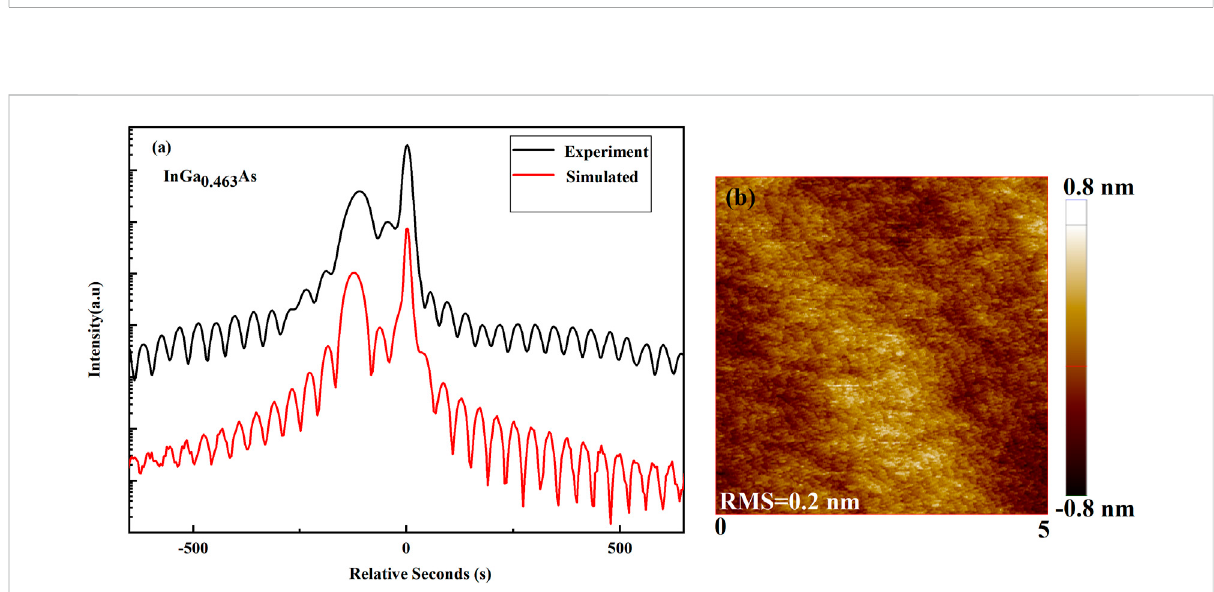
FIGURE 2 (A) Typical double crystal X-ray diffraction results. Simulated diffraction plotted along with experimental data shows the excellent